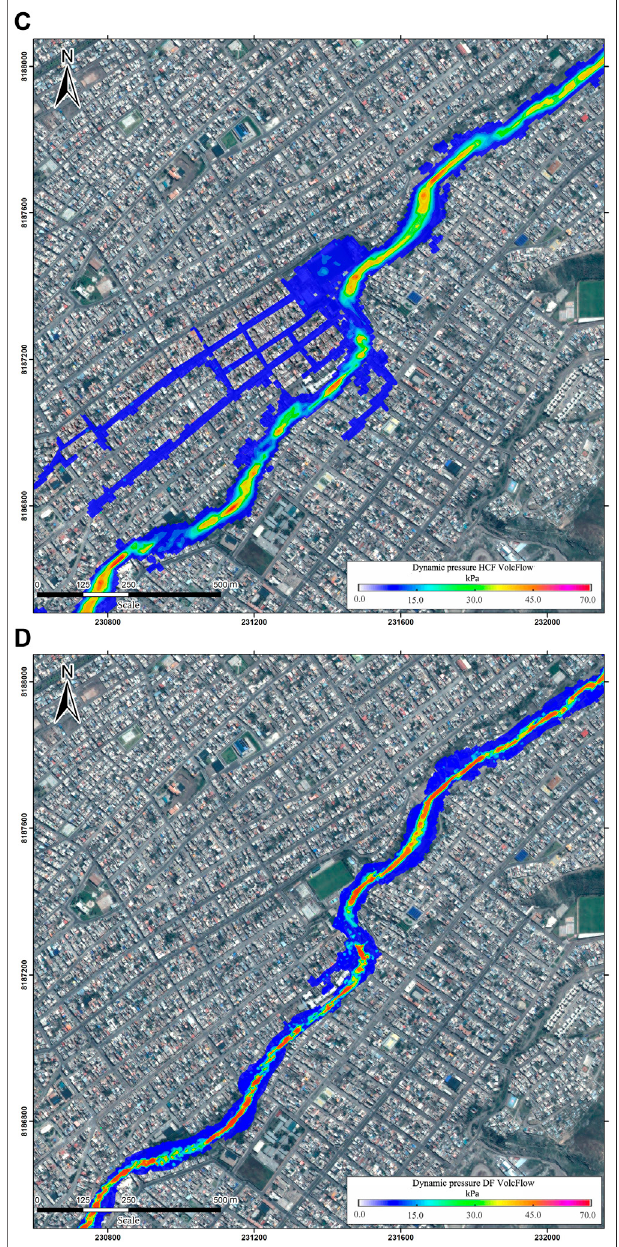
FIGURE 5 | VolcFlow simulation results using three HCF and DF scenarios with 0.15, 0.25, and 0.5 × 10 5 m 3 ( Table 8 for input and output parameters).Extentofsimulated fl owsandoverbankareasforHCF (A) andDF (B) .DynamicpressureofHCF (C) andDF (D) inthemiddlereachofQda. San Lazaro. Inset diagram shows the hydrograph used for three volumes of HCFs and